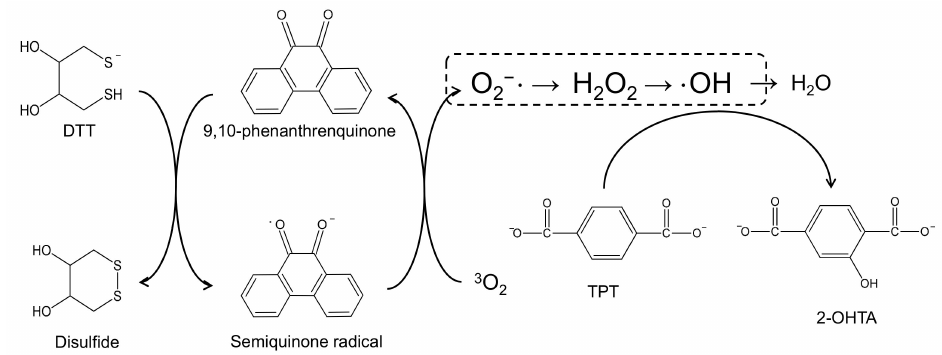
Figure 1. Production of O 2 −· by the reaction of certain redox-active substances with DTT and the measurement of · OH production potential using TPT. Herein, 9,10-phenanthrenequine is shown as an example of a typical redox-active substance in PM 2.5